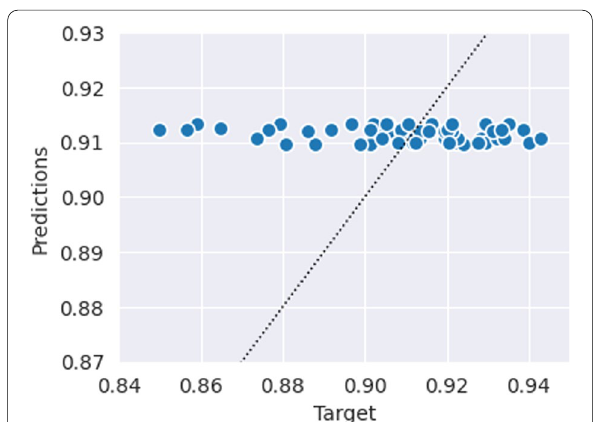
Fig. 3 Predicted vs. target Dice values of the baseline CatBoost model, which only uses clinical variables to predict segmentation quality. The dotted line indicates perfect x y predictions. The = predictions of this model tend to only vary minimally (very close to the naïve model), suggesting that the clinical variables are not indicative of segmentation